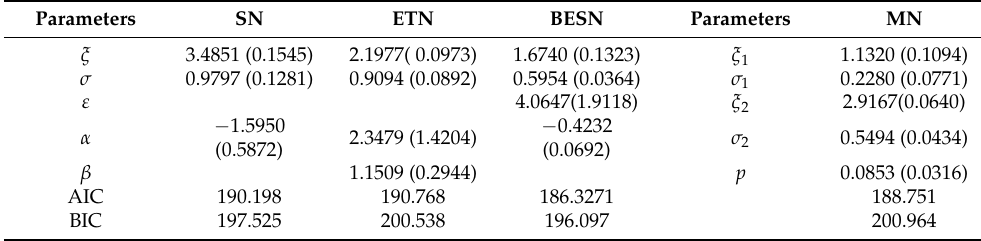
Table 7. Estimated parameters and AIC and BIC for the SN, ETN, BESN and MN distributions. The respective SE are in